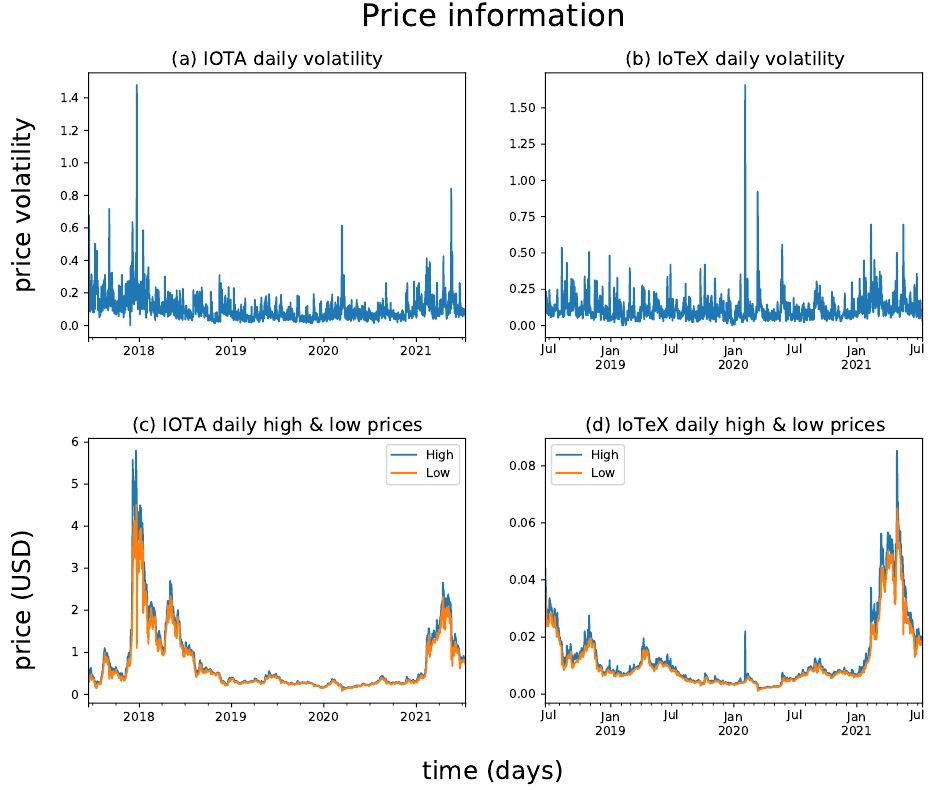
Figure 1. Daily price volatility data for IOTA and IoTeX. Subplots ( a , b ) display the daily volatility time series for IOTA and IoTeX, respectively. Subplots ( c , d ) display their components: highest and lowest prices in USD per day for IOTA and